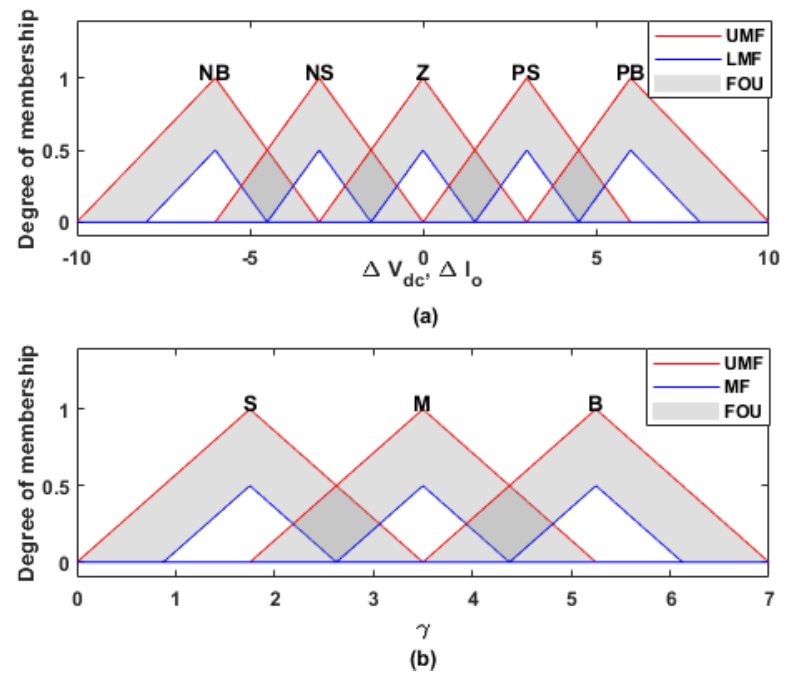
Figure 4. FOU of type-II fuzzy logic membership functions. Table 1. Table of fuzzy